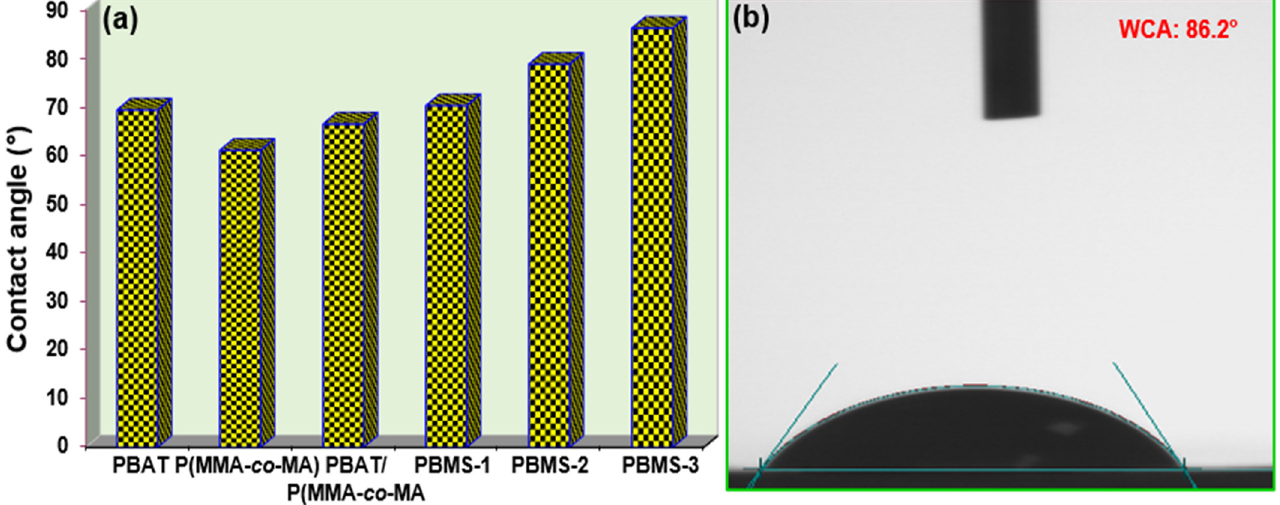
Figure 10. Contact angle of composite film samples ( a ) and PBAT/P(MMA- co -MA)–SiO 2 (5.0 wt.%) image ( b ).